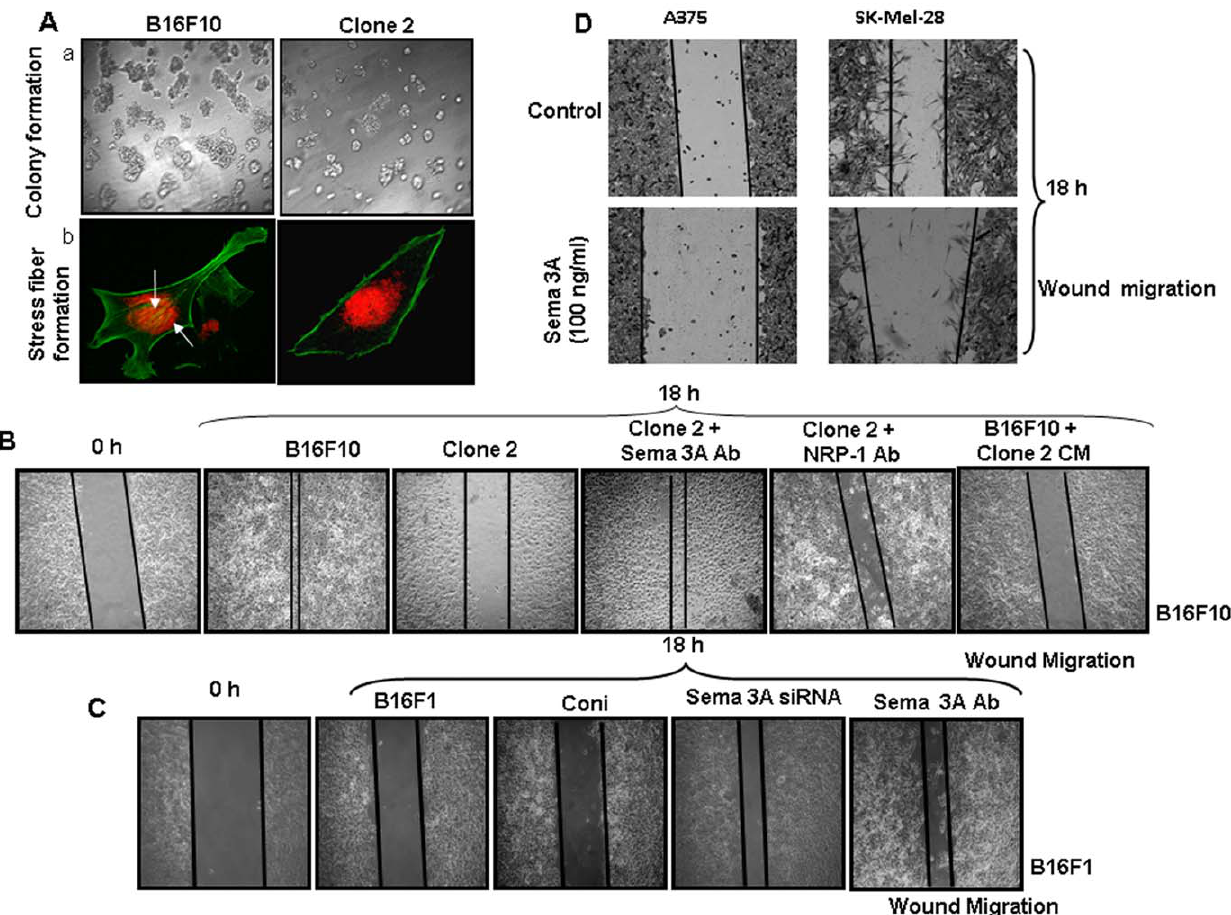
Figure 2. Loss-and-gain of Sema 3A functions and it’s correlation with metastatic phenotype of melanoma cells. ( A ) panel a, equal number of control B16F10 and clone 2 cells (1 6 10 4 ) were grown on matrigel coated plate and incubated at 37 u C for 7 days. Colony photographs were taken at 10 6 magnification. Panel b, control B16F10 and clone 2 cells (1 6 10 4 ) were plated on fibronectin coated coverslips and incubated for 6 h. Cells were fixed in 2% PFA and stained with FITC-conjugated phalloidin (green). Stress fibers were shown by arrows. Nuclei were stained with PI (red). Photographs were taken at 60 6 magnification. ( B ) The effect of Sema 3A on B16F10 cell motility was performed by wound migration assay. Control B16F10 or clone 2 positive cells were used for wound migration. In separate experiments, clone 2 positive cells either treated with